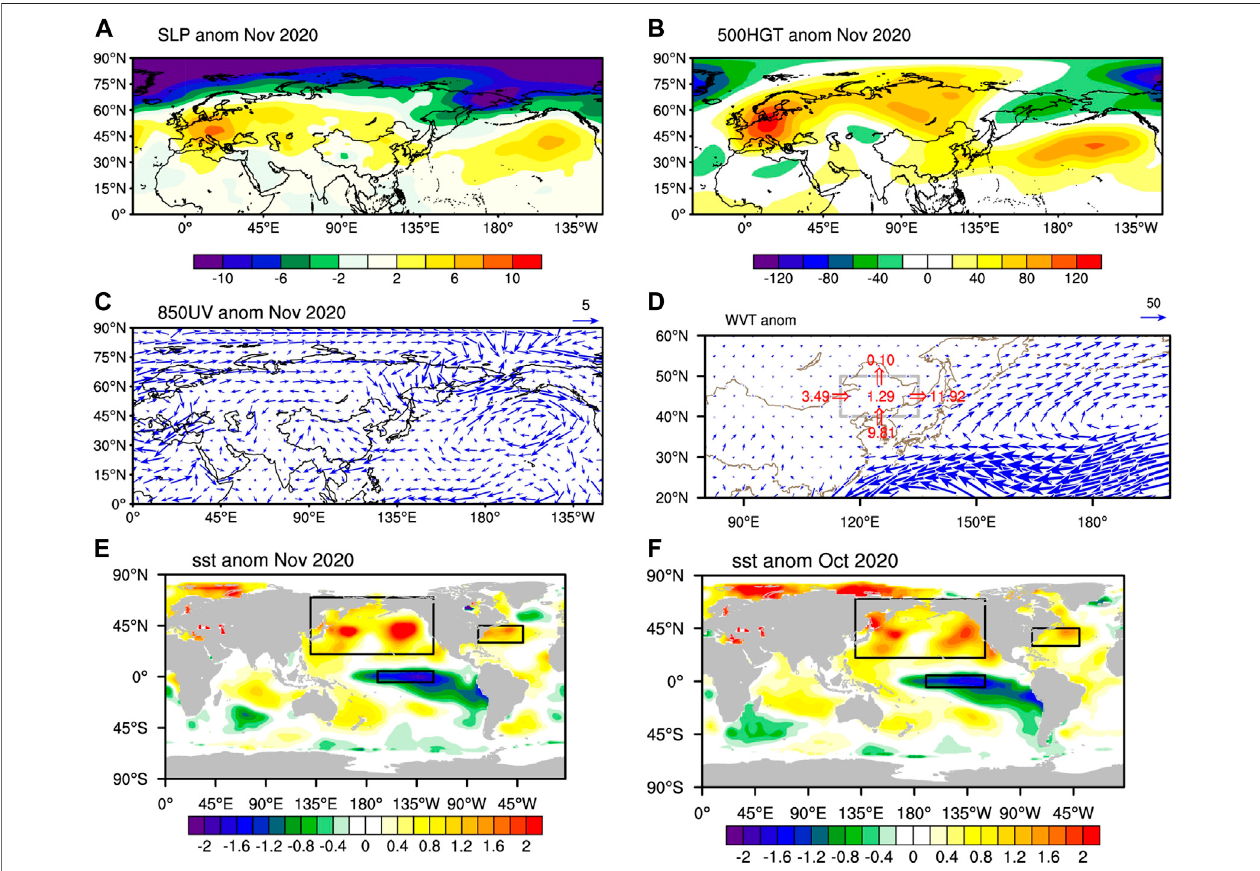
FIGURE 5 | The anomalous (A) SLP (unit: hPa), (B) 500-hPa geopotential height (HGT) (unit: gpm), (C) 850-hPa winds (unit: m s − 1 ), (D) vertically integrated WVT (unit: kg m − 1 s − 1 ) and WVT budget; (E) sea surface temperature (SST) (unit: ° C) in November 2020; (F) SST in October 2020. Anomalies are the departure from the 1979 – 2019 base period monthly means.